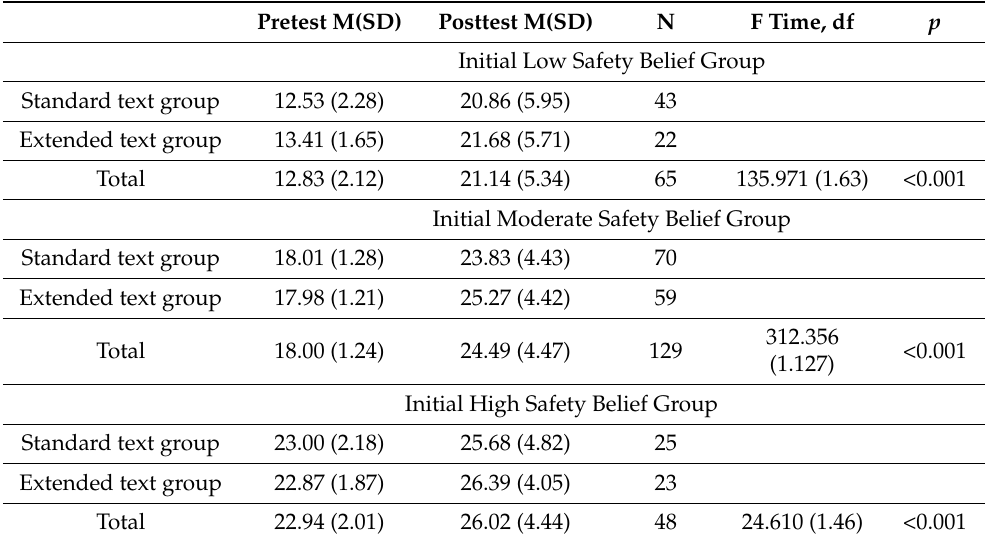
Table 2. Post-reading perception of HPV vaccination safety for groups with different initial